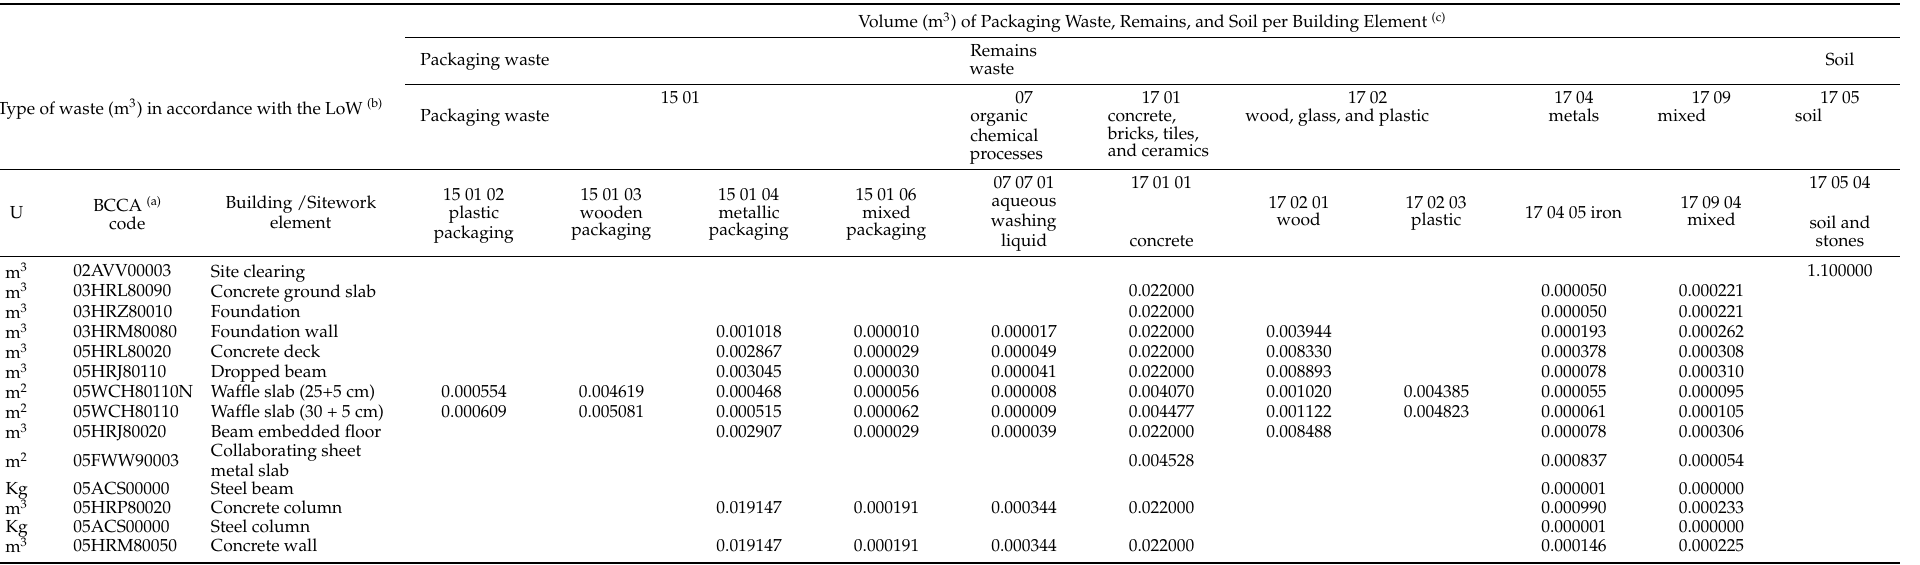
Table 2. Expected CW in building elements. Data based on Llatas (2011) [37] and Llatas and Osmani (2016) [38]. Volume (m 3 ) of Packaging Waste, Remains, and Soil per Building Element